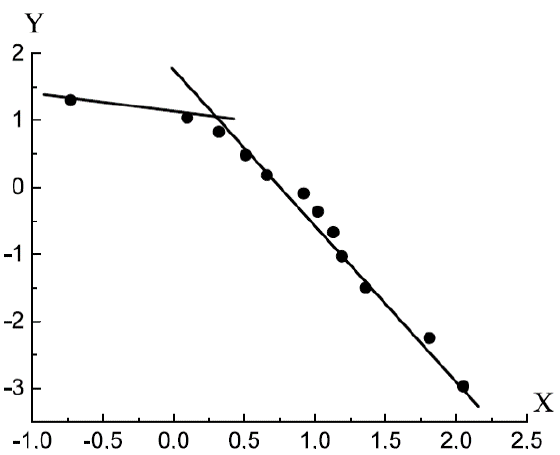
Figure 3. Adsorption isotherm of nitrogen on the coal sample [15] in the coordinates of Equation (28): Y = ln( − ln x); X = ( ln a / a m ) .